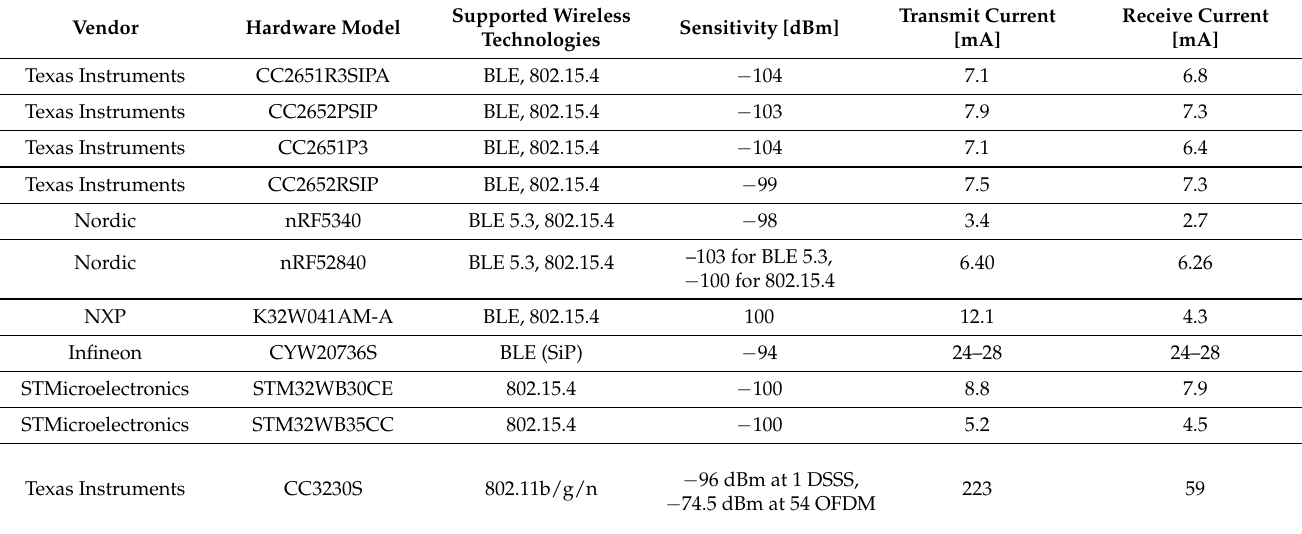
Table 4. Comparison of industrial IoT-compliant devices from different